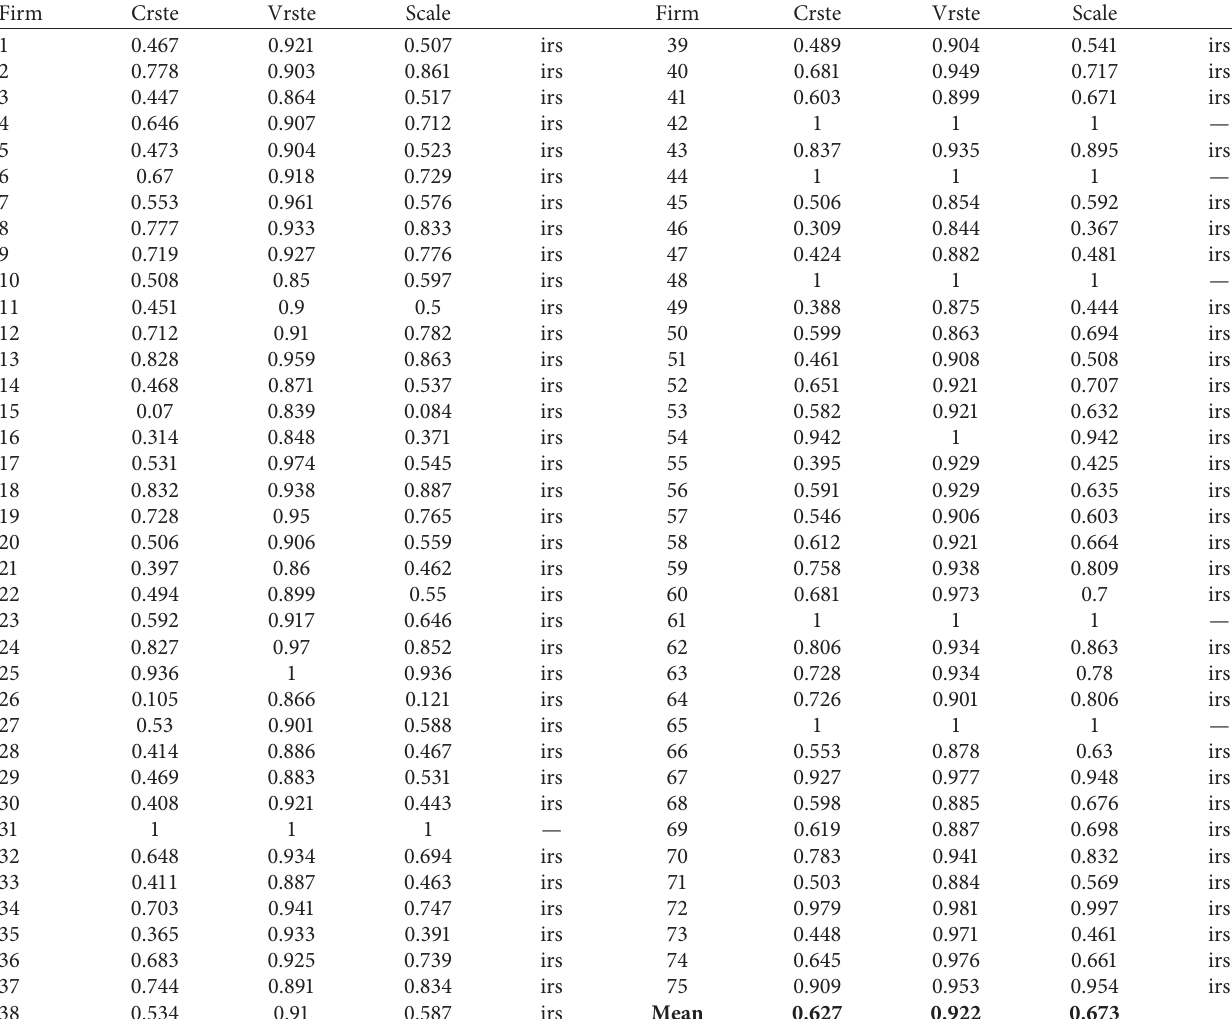
Table 9: Output results of innovation